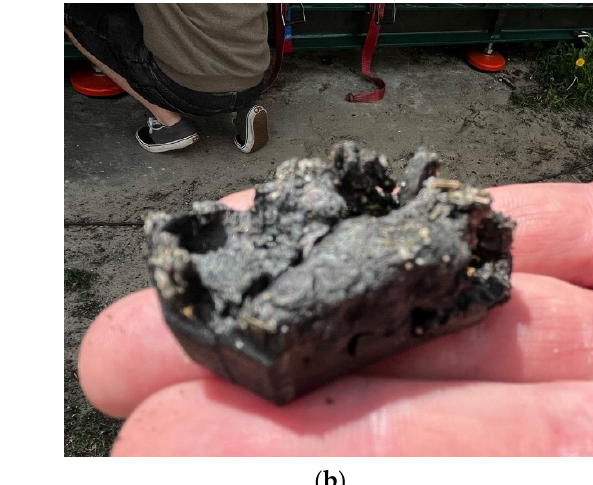
Figure 13. Damaged tire due to overheating: ( a ) view of the tire, ( b ) view of the broken part of the tread (authors’ source).